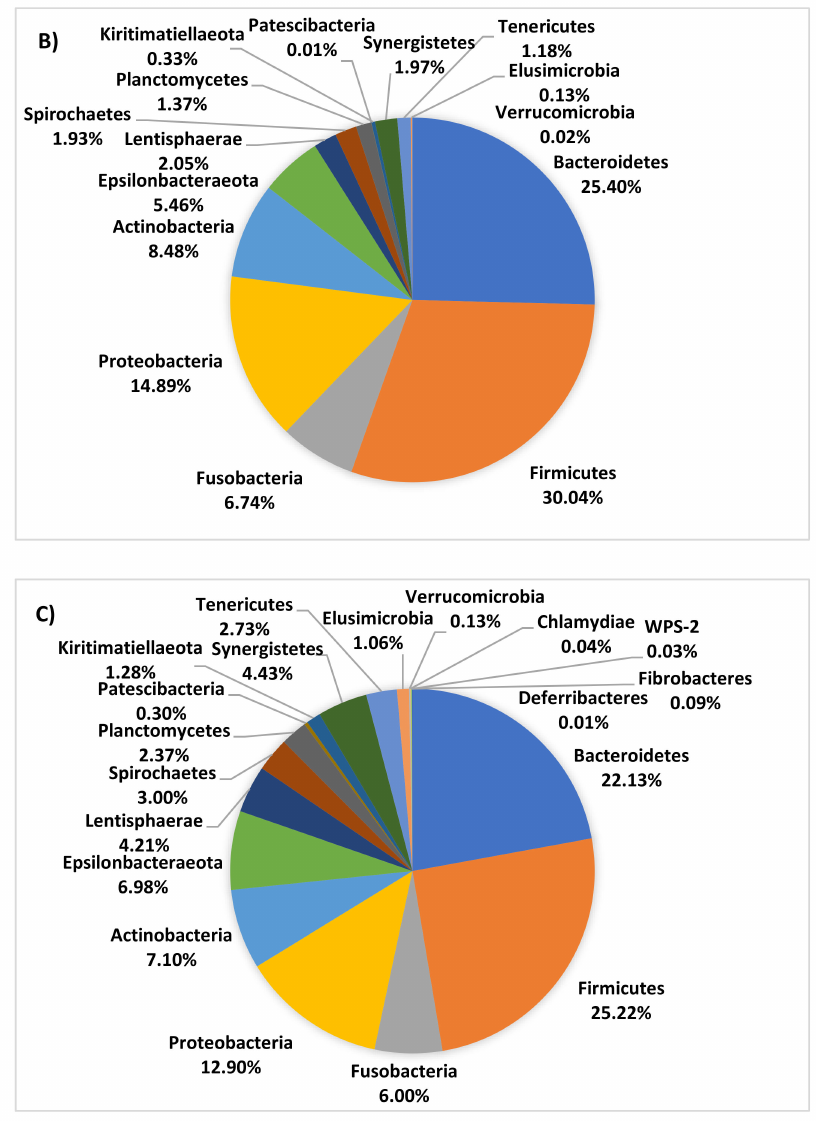
Figure 3. Pie charts of faecal bacteria phyla present at 7 ( A ), 13 ( B ), and 18 ( C ) days of